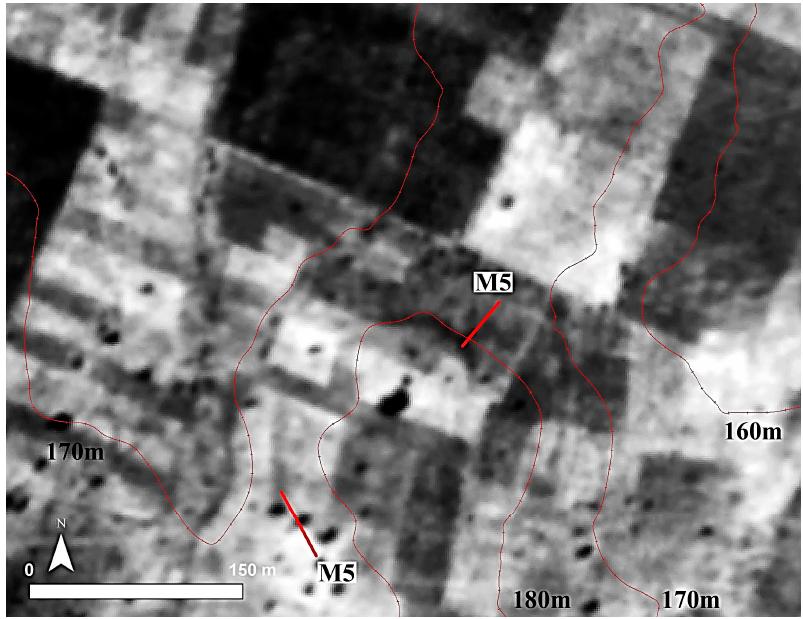
Figure 8. Historic aerial photograph dated to 1945 reveals two potential ditches, which are no longer visible in modern imagery. The modern elevation contours range between 160 m and 180 m within the area.